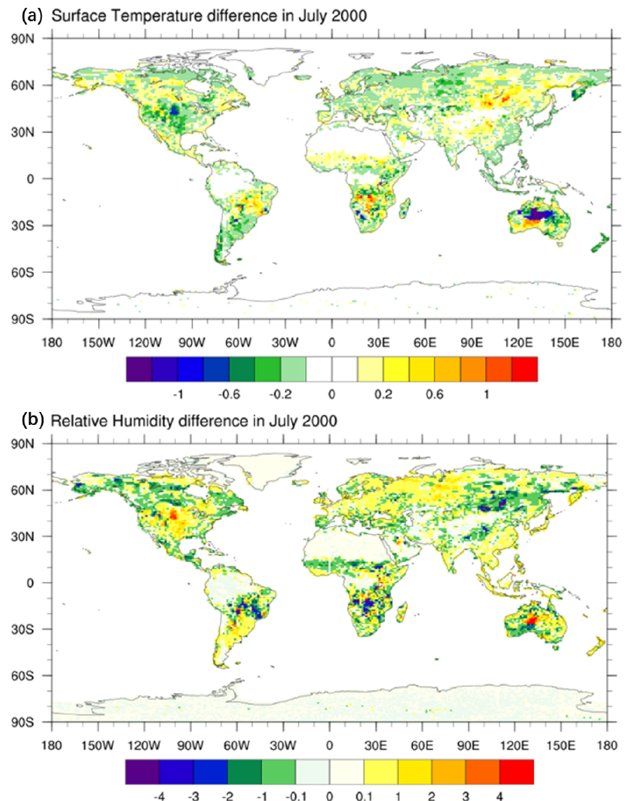
Figure 7. The difference of ESACCI and CLM_LS for ( a ) 2 m air temperature (T2m, unit: °C) and ( b ) relative humidity (RH, unit: %) (July 2000).